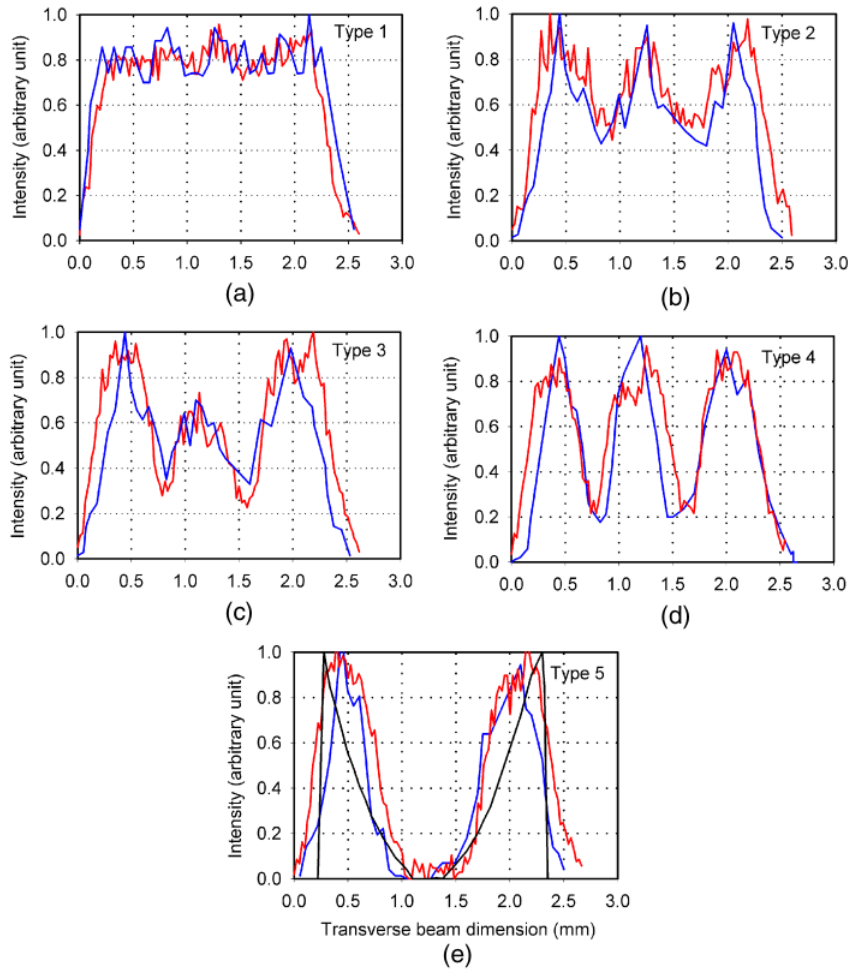
FIG. 2. (Color) Distribution of transverse laser beam slices along a beam diameter for the various distribution types. In addition to the measured data (in red), we show also the data used for simulations (in blue) or analysis (in